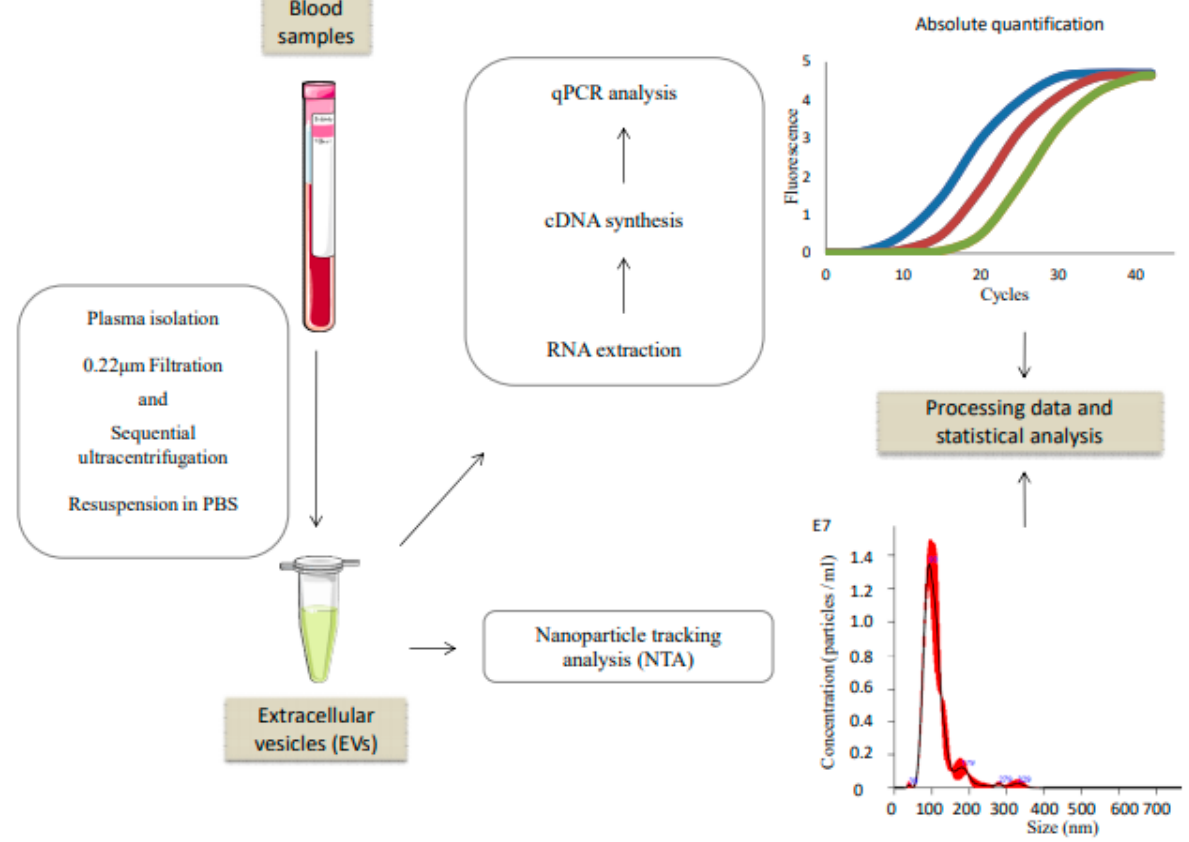
Figure 1. Scheme of the experimental workflow.